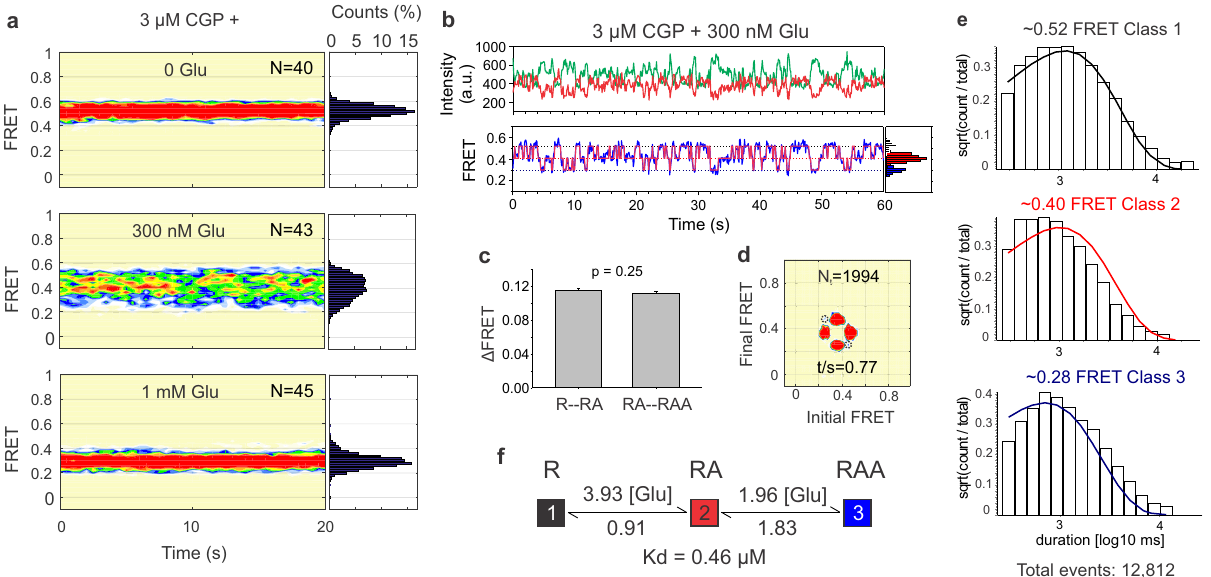
Fig. 2 Kinetic modeling of glutamate binding. a Population FRET contour plots and its corresponding cumulative population histograms (on the right) for receptors treated by 3 µ M CGP and 0, 300 nM, and 1 mM glutamate. Each contour plot contains FRET traces from one movie, N number of molecules. b Representative donor (green) and acceptor (red) intensity traces (top) and the corresponding smFRET trace (blue) with 3-state SKM idealization (magenta, bottom) in 3 µ M CGP and 300 nM glutamate. Histograms, assigned to high, middle, and low FRET levels, are plotted on the right in black, red, and blue, respectively. c Glutamate binding increases ATD interdimer distance in two discrete steps whose 4 FRET values are not signi fi cantly different ( P = 0.25, two-tailed paired t test, n = 11, SEM error bars). d Transition-density plots from a representative movie show FRET values before (initial) and after ( fi nal) each transition ( t /s = average number of transitions per second; N t = total transitions per movie). Dotted circles indicate void at locations of direct transition between high and low FRET levels, indicating extreme rarity, i.e., transitions between high and low FRET go almost exclusively through the intermediate FRET state. e Dwell-time histograms for high, middle, and low FRET states fi tted by kinetic model in ( f ). Total events indicate the total number of dwell times analyzed in all three histograms. f Kinetic scheme of glutamate binding to NMDAR. Resting (R), single-glutamate-binding site occupied (RA), both glutamate-binding sites occupied (RAA). The reaction mechanism illustrates association and dissociation rate constants (in µ M − 1 s − 1 and s − 1 ) that are consistent with two identical, independent binding events and a Kd similar to the activated-state glutamate EC 50 dose – response (Fig. conformational rearrangement triggered by glutamate binding to one of the two GluN2B LBDs. Hidden Markov modeling provided a good fi t to three states (Fig. 2e), corresponding to the FRET levels identi fi ed above (Fig. 1d), and organized in a linear two-step scheme (Fig. 2f). Alternate schemes either did not converge or produced kinetic models with very low-probability transitions that did not match the observations. In the successful model, the forward (activation) rate of the fi rst step (from high to intermediate FRET) was twice that of the second step (intermediate-to-low FRET), and the same was true in reverse (deactivation), where the fi rst step (low-to- intermediate FRET) was twice as fast as the second step (intermediate-to-high FRET) (Fig. 2f). This behavior suggests two independent, successive steps of glutamate binding to the GluN2B LBDs, triggering two identical ATD dimer separation rearrangements. The model predicts a glutamate dissociation constant (Kd = 0.46 µM) that is very similar to the observed EC 50 (0.60 µM) (Fig. 1e), strongly supporting the model.